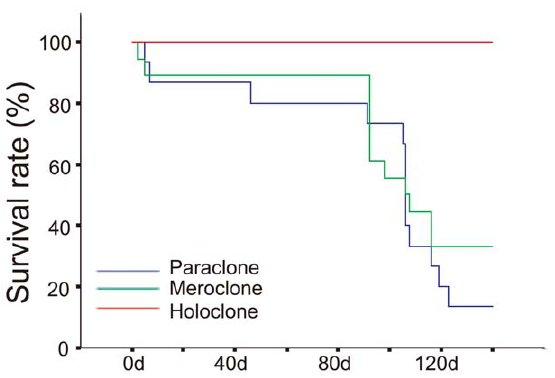
Figure 3. Long-term propagation capacity of distinct types of colonies. Holoclones (n=12, red line), meroclones (n=18, green line) and paraclones (n=15, blue line) were cultured in common condition for 20 weeks and life spans of each colony were recorded. Most of the meroclones and paraclones were aborted gradually, whereas all the holoclones remained viable (p , 0.01).